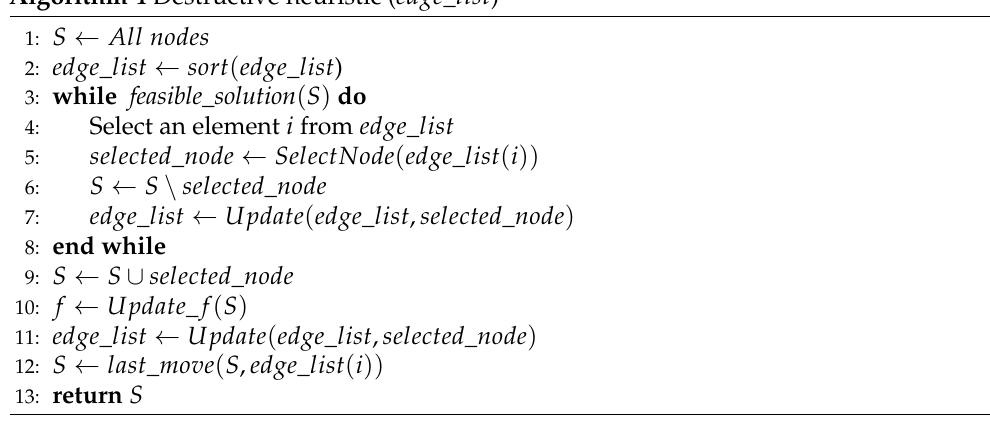
Algorithm 4 Destructive heuristic ( edge _ list )